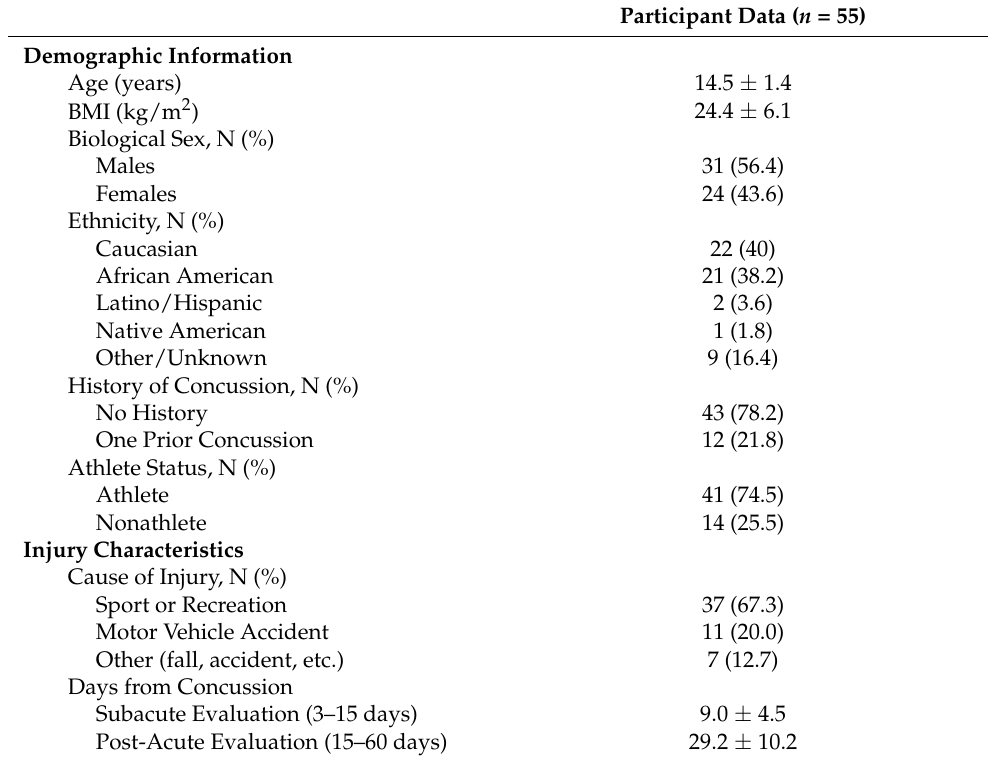
Table 1. Participant demographic information and injury characteristics.